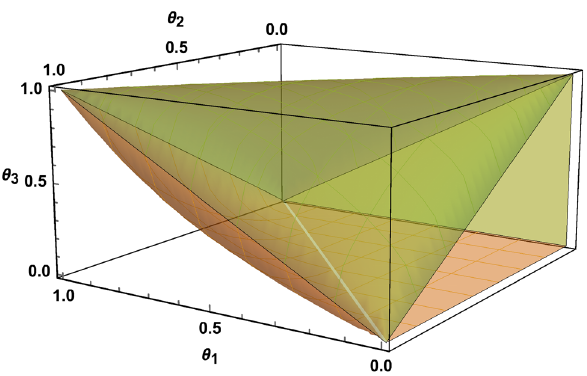
Fig. 1 Allowed space for the orbit parameters θ 1 , 2 , 3 defined in Eq. (26). Note that the allowed volume in this space is not a cube, but a closed volume with boundaries given in Eq. (27). Here, it is important toremarkthatasimilarreductionoftheorbitparameterspacehappensin the context of the triplet seesaw model [80]. In that case, the relation on the boundary between the two orbit parameters makes that the allowed space is not longer a box. Thus, the stability conditions at tree level in that model are modified to a set less restrictive, correcting what